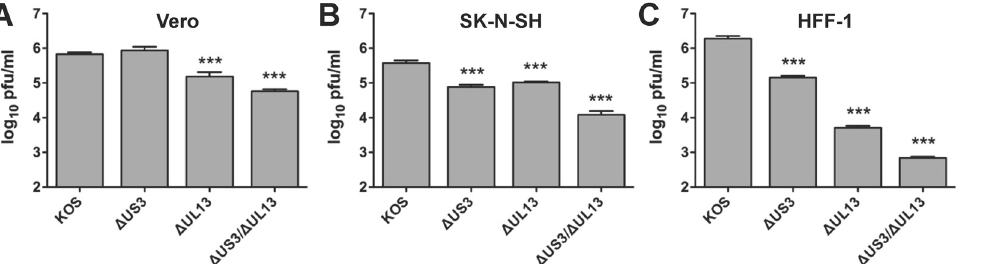
Fig 8. HSV-1 kinase mutants are attenuated in different cell types. Monolayers of (A) Vero, (B) SK-N-SH, and (C) HFF-1 cells were inoculated with wild type HSV-1 KOS or HSV-1 Δ US3 , Δ UL13 , and Δ UL13/ Δ US3 mutants at an MOI of 0.1 pfu per cell and incubated for 24 hours. Virus yields were determined by plaque assay on Vero cells. Results are presented as the mean virus yield ± sem (n = 6; *** — p <